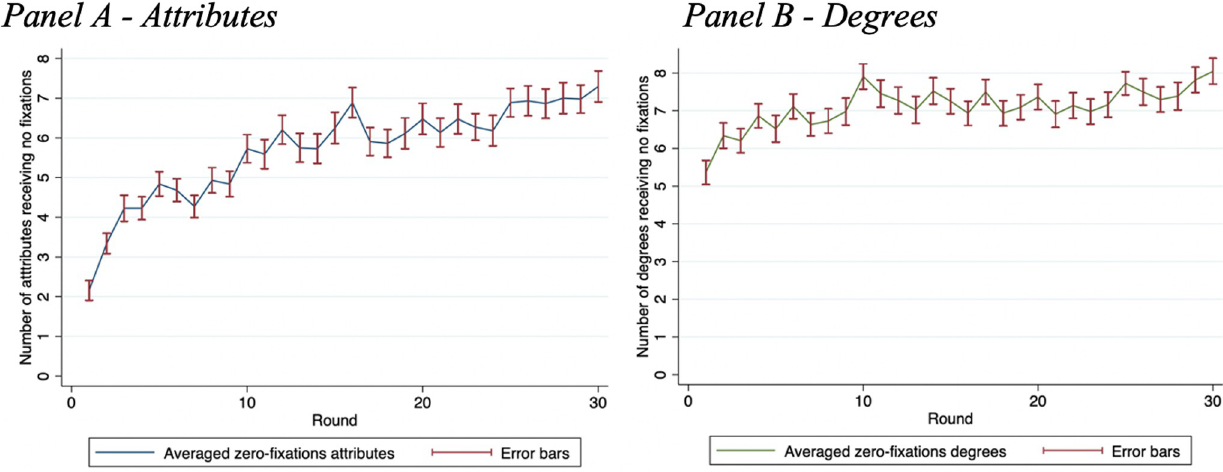
Fig 2. Zero-fixations attributes and degrees. Distribution of zero-fixations attributes over the succeeding scenarios for attributes (Panel A) and degrees (Panel B). The error bars are depicted in dark red.